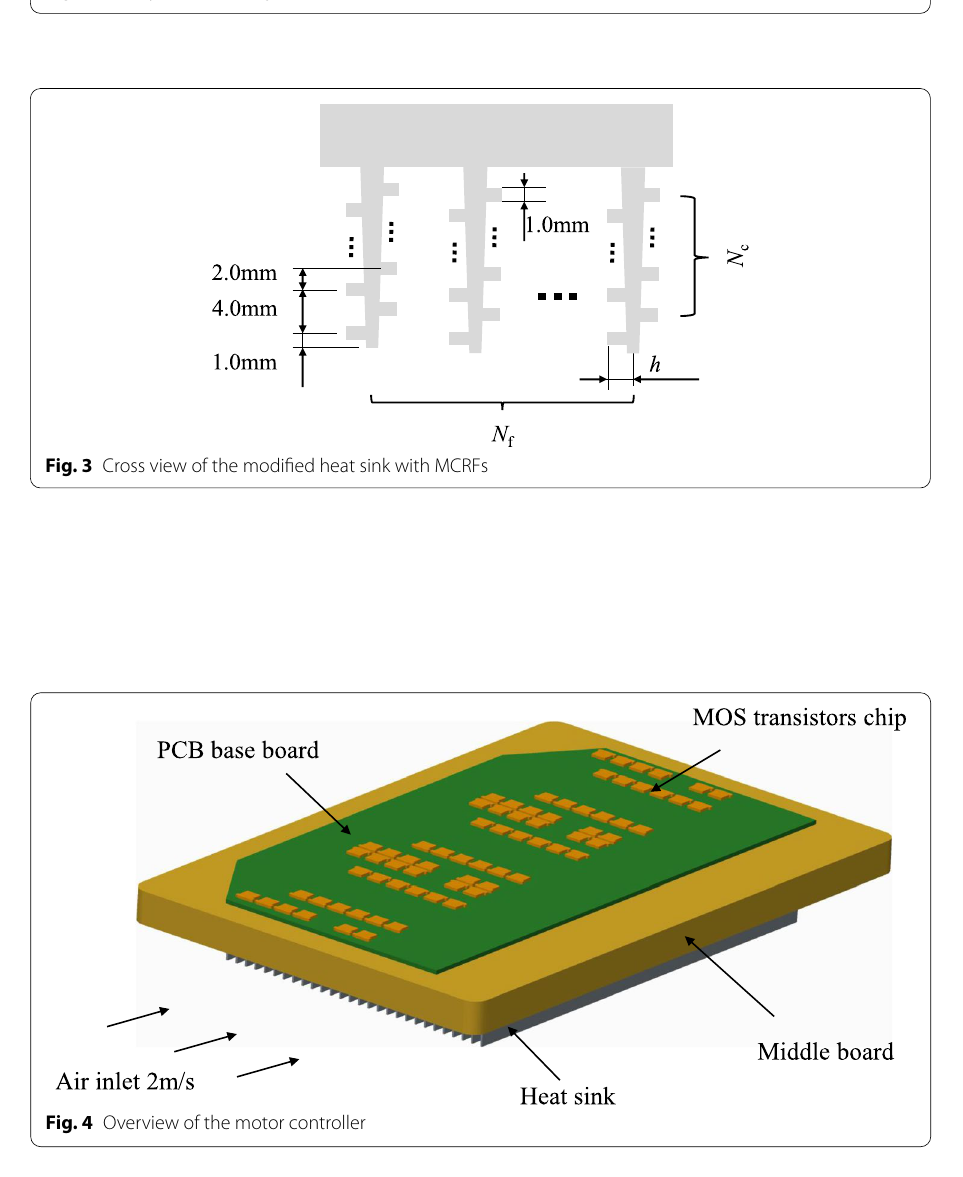
Fig. 2 The layout of the original heat sink with smooth fins